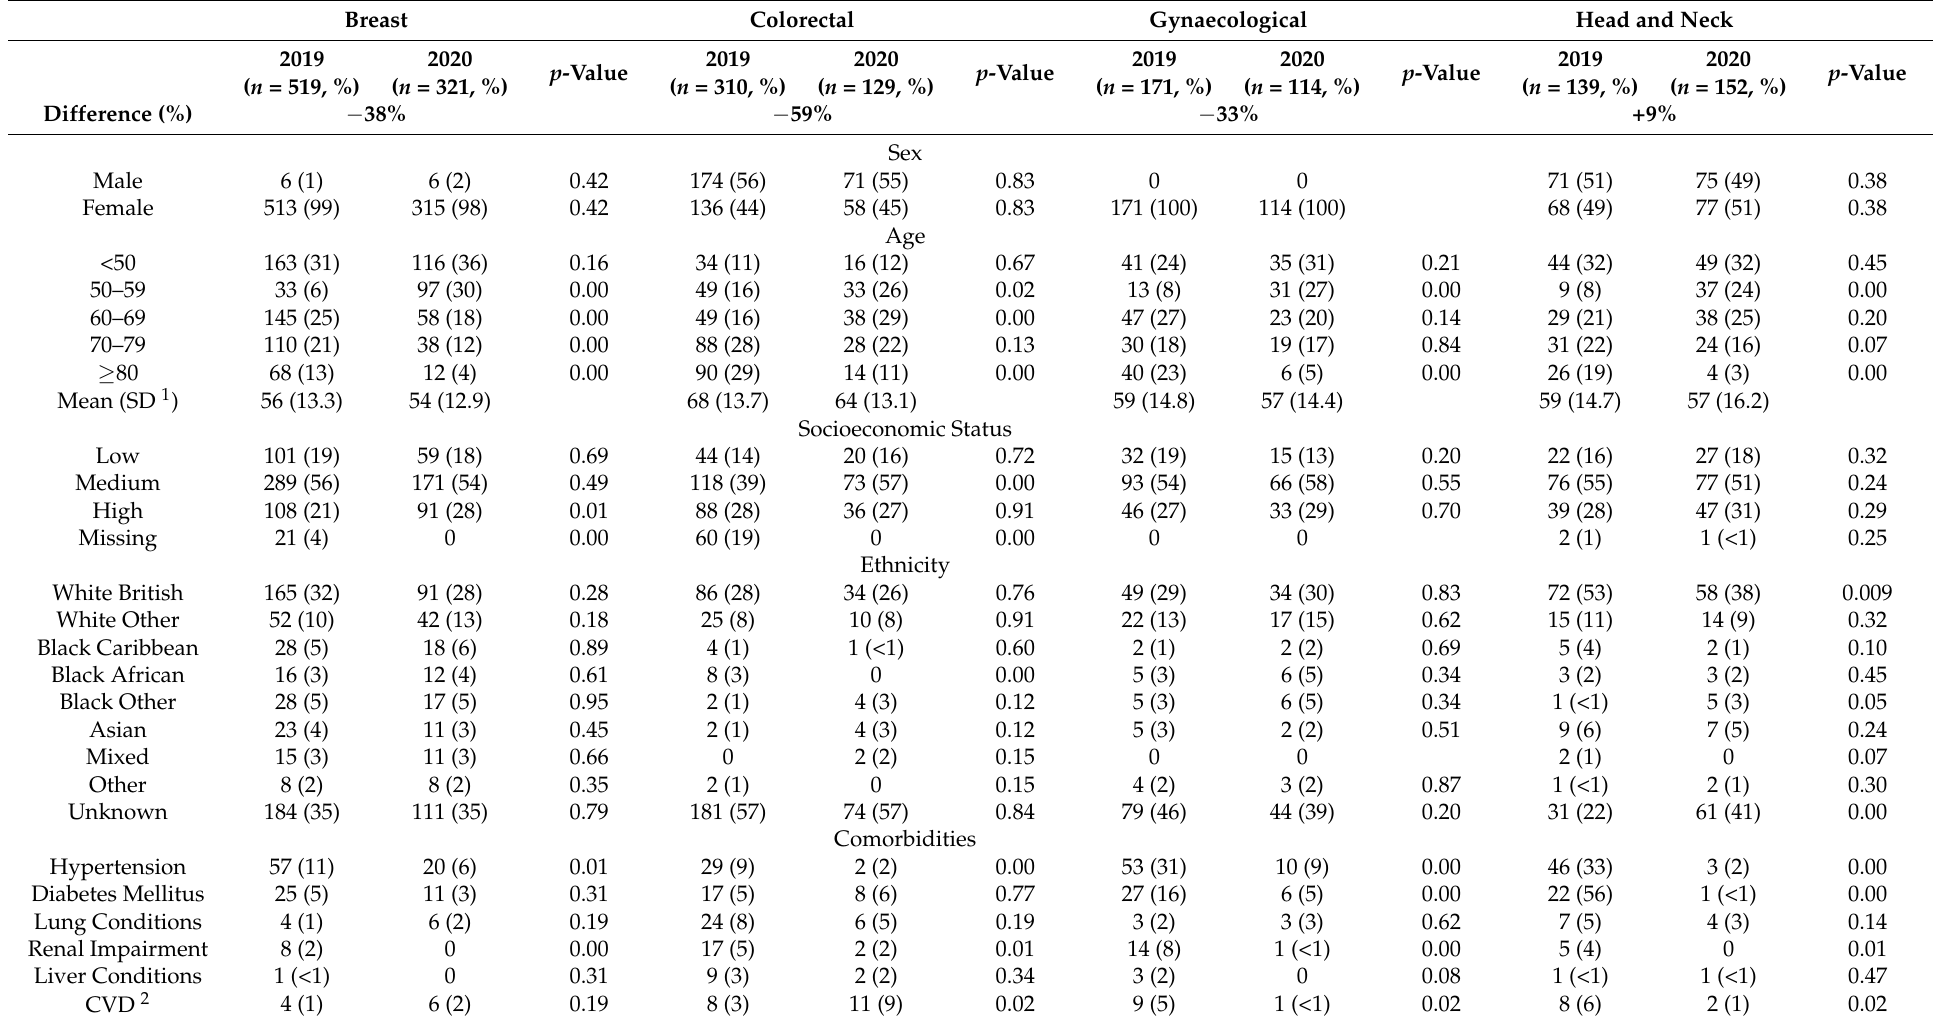
Table 4. SELCA patient characteristics of cancer patients receiving radical surgery between 23 March 2019–8 September 2019 and 23 March 2020–8 September 2020, divided by cancer site. Breast Colorectal Gynaecological Head and